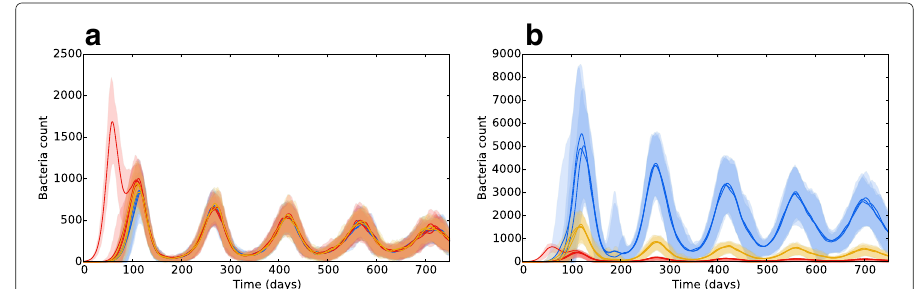
Fig.7 Theoverallbacterialgrowth( B ER , B ED , B IM and B ID )uponamultiplepatchtopology.Patchesaregrouped by spatial location (base, middle and apex). Line is mean, shading is standard deviation. All simulations use